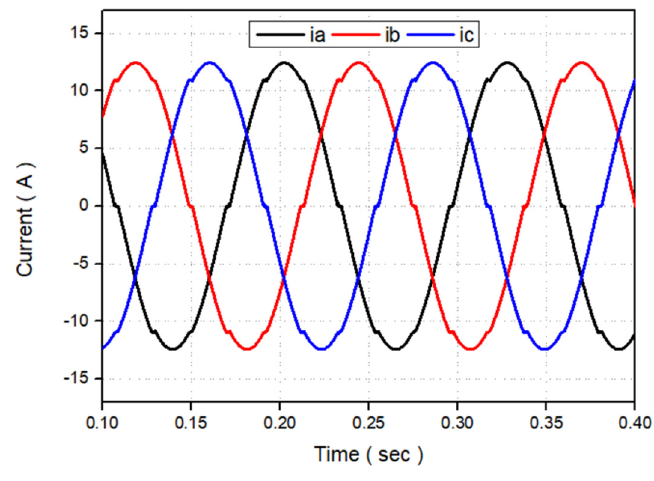
Figure 11. Three − phase current waveform with harmonics as the disturbance voltage generated during dead time.